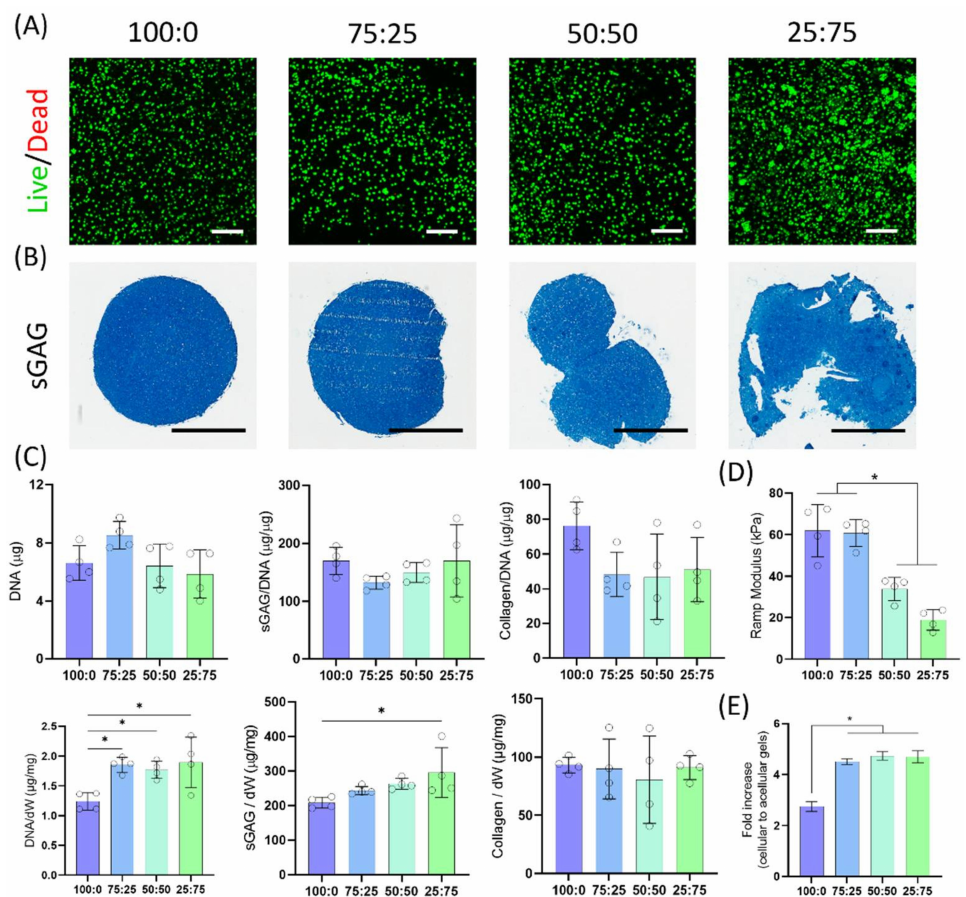
Figure 4. Chondrogenic evaluation of the bioinks. ( A ) Representative images of the live/dead staining at day 7. Green and red indicate live and dead cells, respectively. Scale bars are equal to 200 µ m. ( B ) Alcian blue staining for sulphated glycosaminoglycan (sGAG). Scale bars are equal to 2 mm. ( C ) Quantification of DNA, sGAG and collagen deposition in each construct at day 28. ( D ) Ramp modulus of the constructs derived from the linear region of compressive strain-stress curves after 28 days in culture. ( E ) Fold change in the ramp modulus of acellular and cellular hydrogels following 4 weeks of in vitro culture. * indicates significance p <